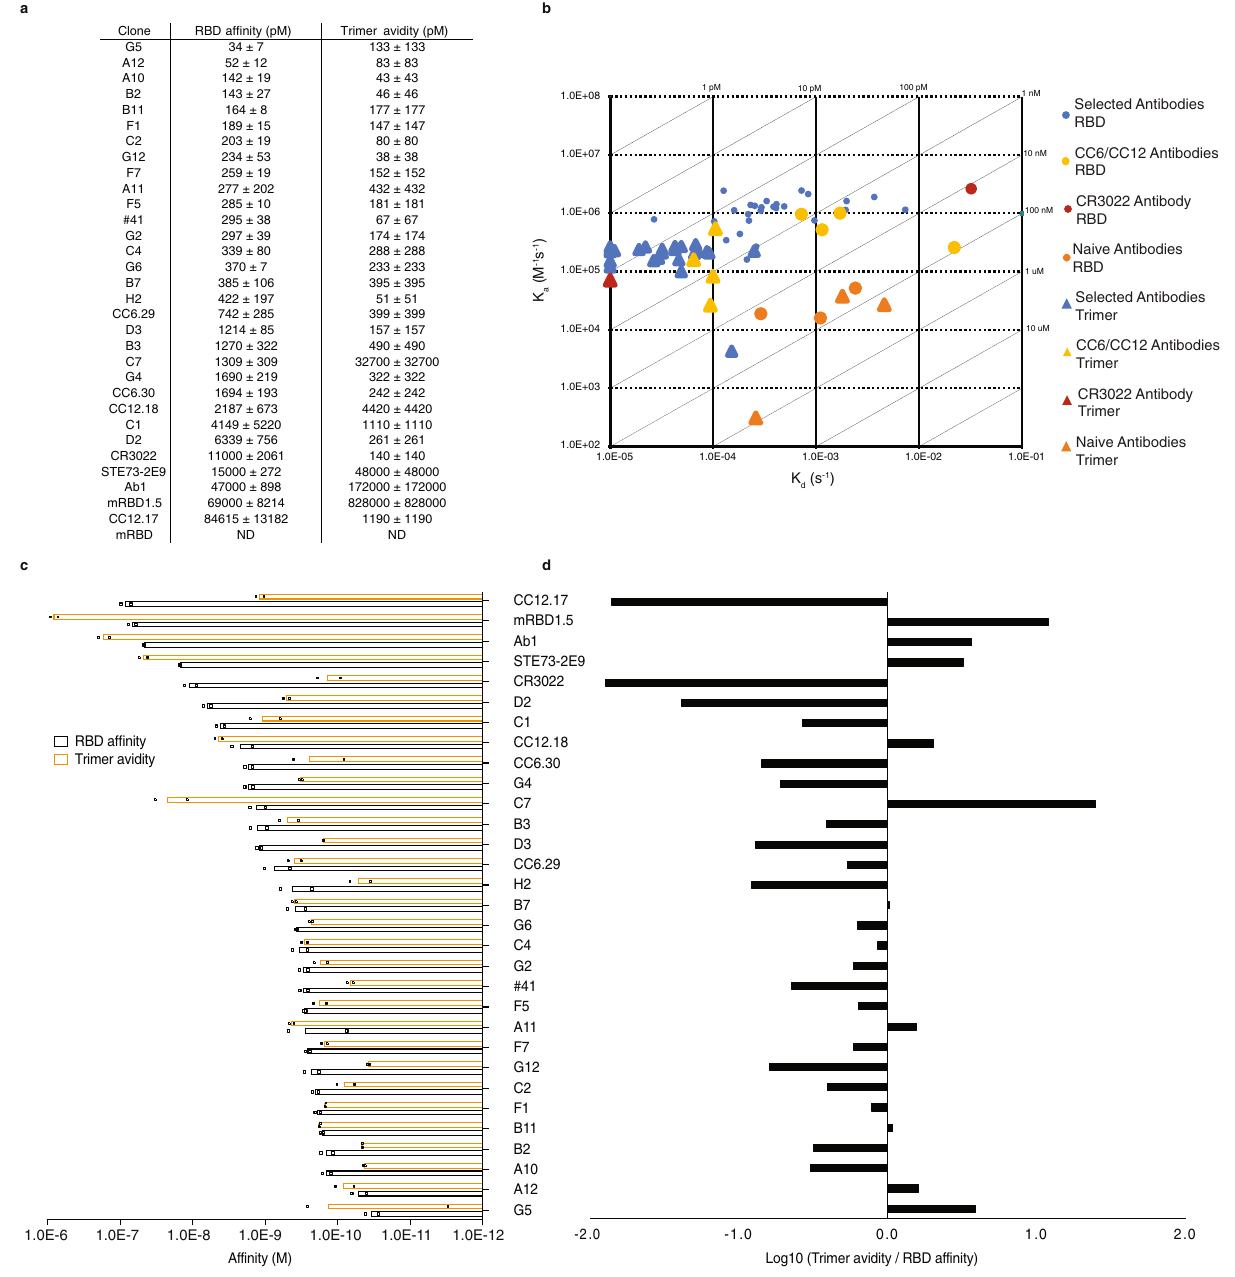
Fig. 2 Kinetic characterization of selected antibodies. a Measured af fi nities and avidities of the selected antibodies (IgGs) against SARS-CoV-2 RBD and trimer respectively. Data represent the average of duplicates of independent af fi nity measurements for each of the tested antibodies ( n = 32) + / − SD. b Isoaf fi nity plot of the antibodies against RBD (circle) and trimer (triangle) plotting off-rate (s − 1 ) against on-rate (M − 1 s − 1 ). Data represent the average of duplicates of independent af fi nity measurements for each of the tested antibodies ( n = 32). c Af fi nity histogram ranked on RBD af fi nities plotted with corresponding trimer avidities. Data represent average of duplicates of independent af fi nity measurements for each of the tested antibodies ( n = 32) + / − SD. d Ratio of the trimer avidity values divided by the RBD af fi nity. Source data are provided as a Source Data